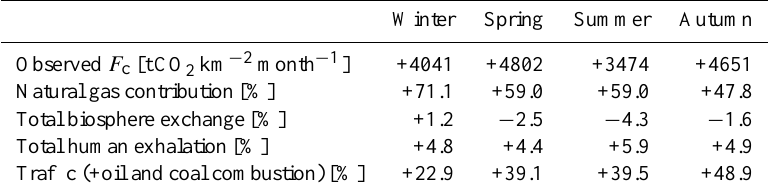
Fig. 9. Weekday-weekend segregation of traffic counts (figures for Marylebone Road used as a proxy for central London), carbon dioxide fluxes measured at the BT Tower and ratio of fluxes to traffic in (a) winter 2007, (b) spring 2007, (c) summer 2007 and (d) autumn 2007. Table 5. Comparison of observed daytime (09:00–18:00) carbon dioxide fluxes ( F c ) with emissions from natural gas usage, biosphere exchange and human respiration (by season in 2007). The relative contribution from traffic emissions is the difference of F c and ground sources. Natural gas usage was estimated from third-party data as described in Sect. 2.2 of the